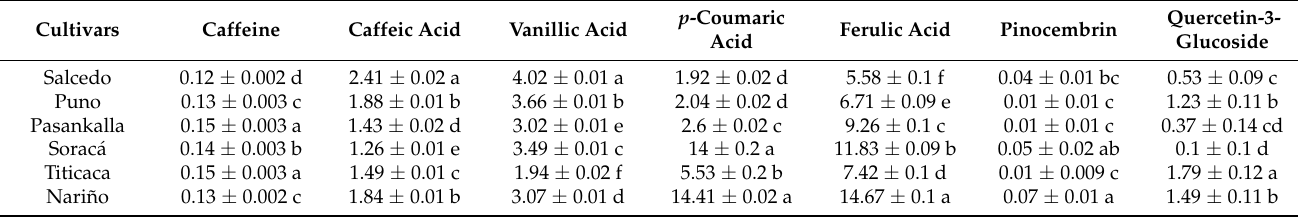
Table 6. Phenolic compound contents (mg/Kg) in quinoa seed samples using UHPLC/ESI+-Orbitrap/MS.